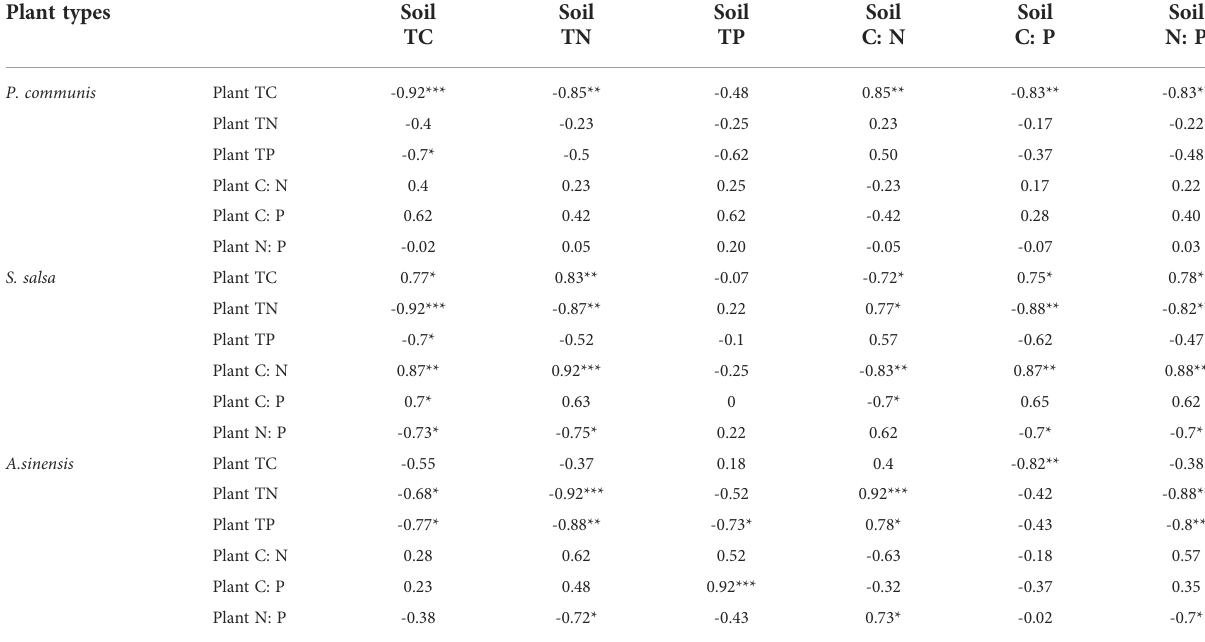
TABLE 1 Correlation between plant and soil ecological stoichiometry of three different halophytes. Plant types